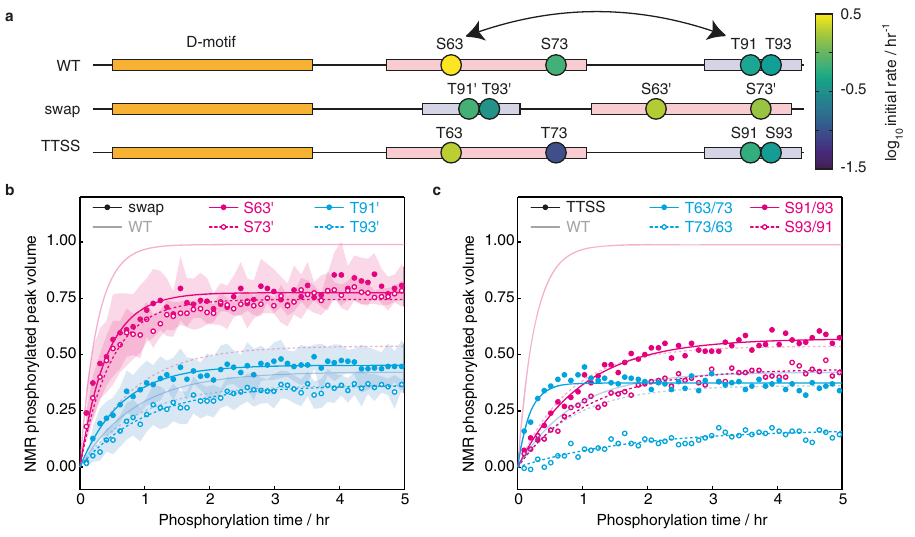
Fig. 4 | Effect of primary sequence of the S/T-P sites on the c-JUN TAD N-terminal phosphorylation kinetics. a Schematic representation of the c-JUN TAD constructs swap and TTSS comparing to wild-type (WT). The initial rate of phosphorylation of residues by JNK1, determined by time-resolved NMR spectro- scopy, is indicated according to the displayedcolour scale. b Site-speci fi c build-up curvesofthephosphorylationofc-JUNswapvariantbyJNK1.Dataareplottedasthe mean±standard error of the mean (SEM) ( n =3 biologically independent samples)